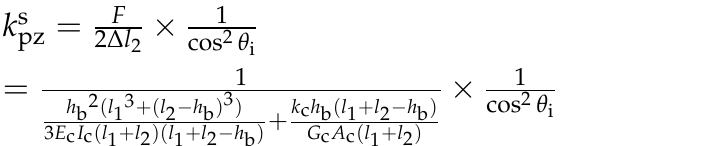
Figure 17. Deformation schematic diagram of the panel zone spring.